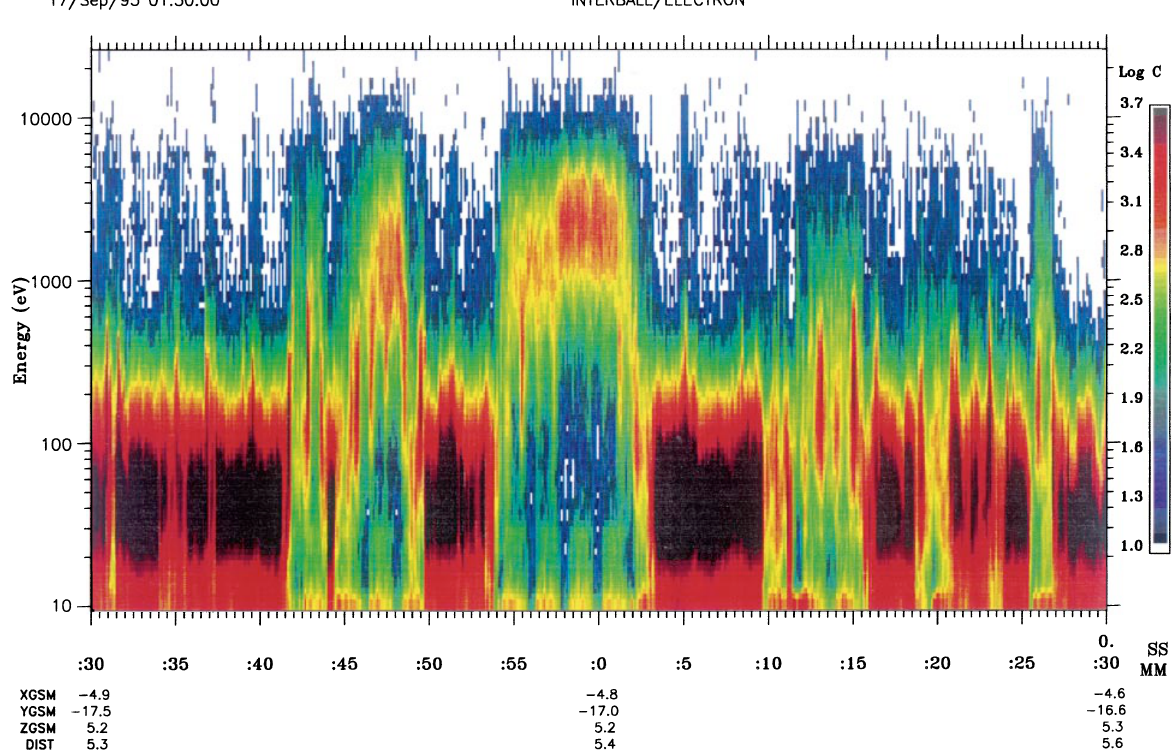
Fig. 5. Same as Fig. 3 for the time-period 01:30 to 02:30 on 17 September 1995, when the satellite encountered the magnetopause many